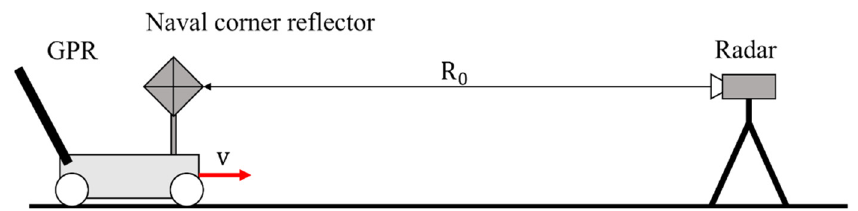
Figure 1. Working principle of microwave interferometric system for GPR positioning.